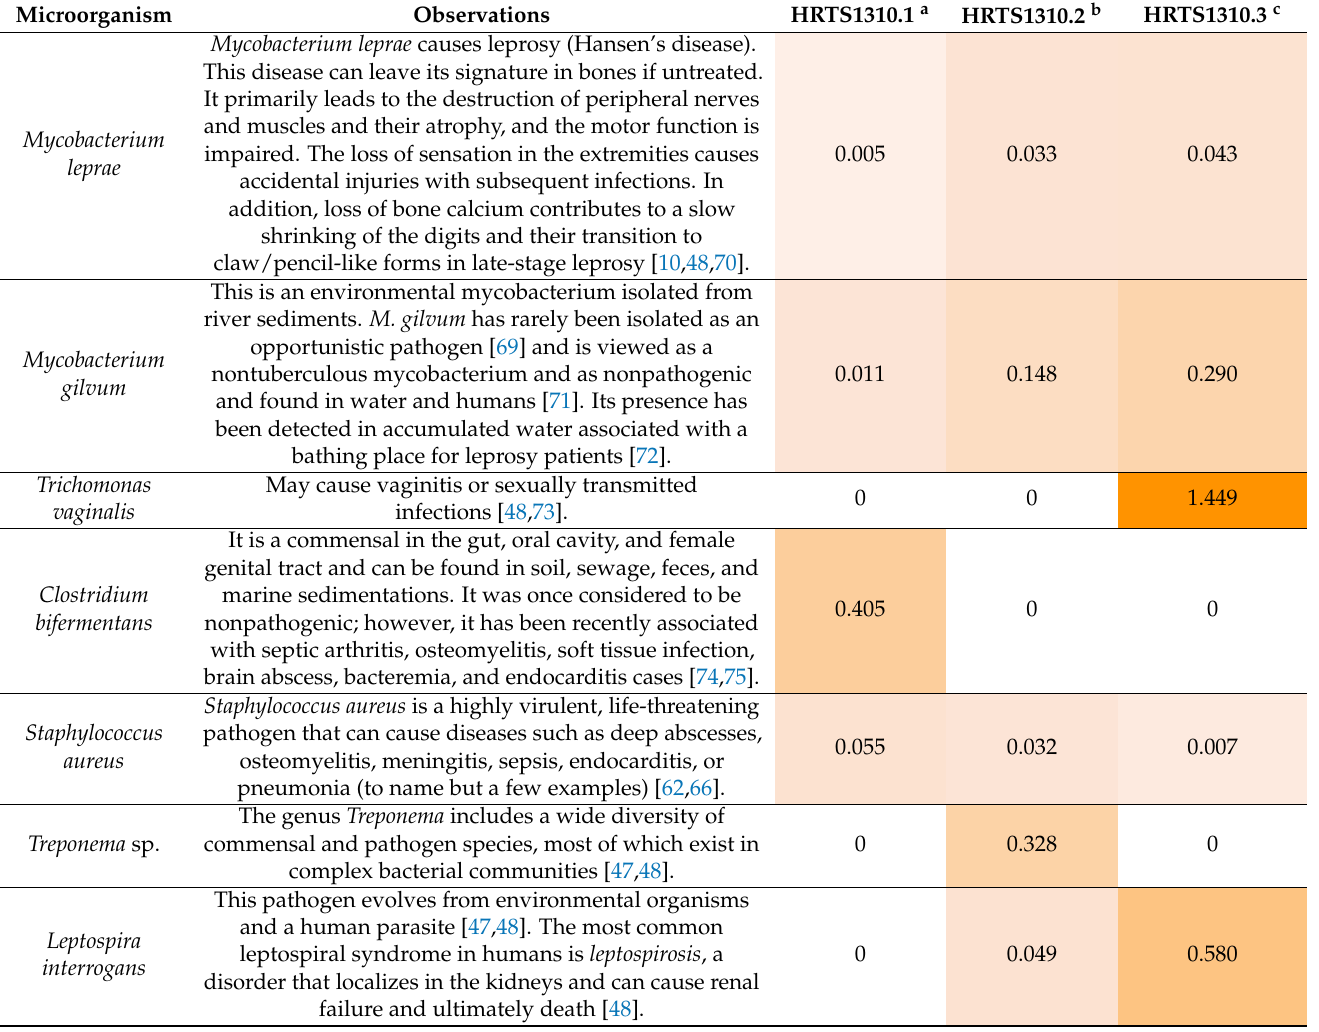
Table 1. List of the most abundant human pathogenic microorganisms found in the various samples of the HRTS SK1310 individual and associated